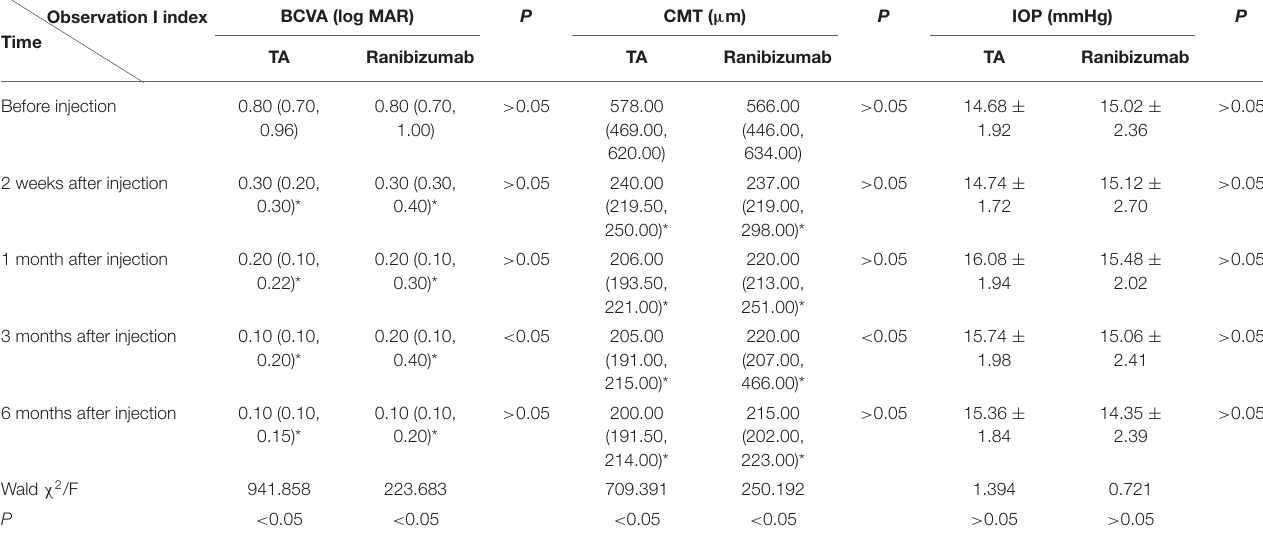
TABLE 1 | Effects of intravitreal injection of triamcinolone acetonide (TA) and ranibizumab on best-corrected visual acuity (BCVA), central macular thickness (CMT), and intraocular pressure (IOP) in patients with pseudophakic cystoid macular edema (PCME). Observation I Time